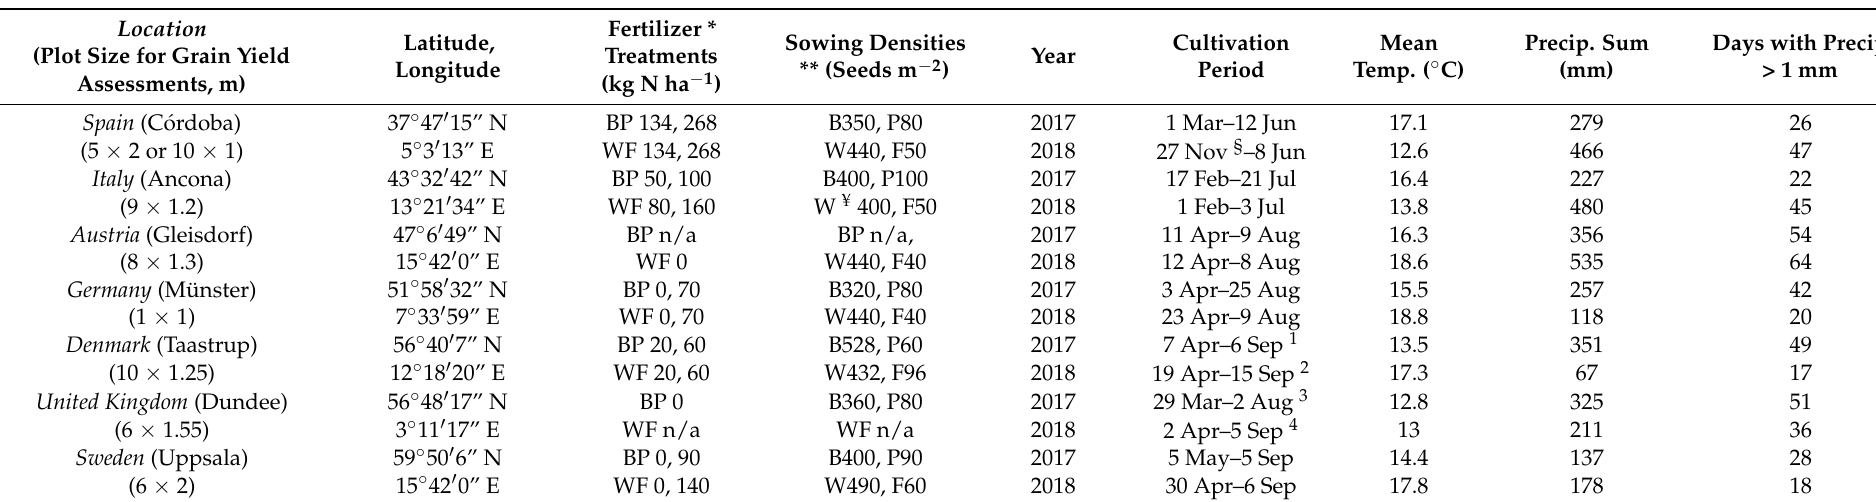
Table 1. Overview of the experimental cereal-legume field trials grown across Europe (from South to North) in 2017 and 2018 and used in the analyses. Four replicate plots in randomized block designs were applied in each trial. Sowing densities are given separately for barley (B) & pea (P) and wheat (W) & faba bean (F) sole crops and intercrops. Mean temperatures and precipitation sums refer to the individual cultivation periods of the seven trials. n/a—not applied.